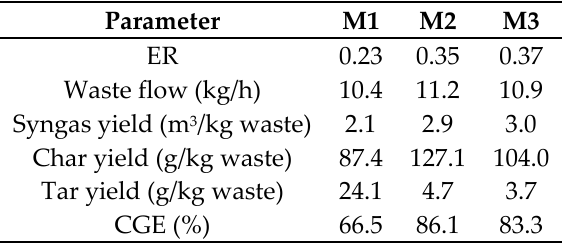
Table 2. Results for gasification performance indicators.